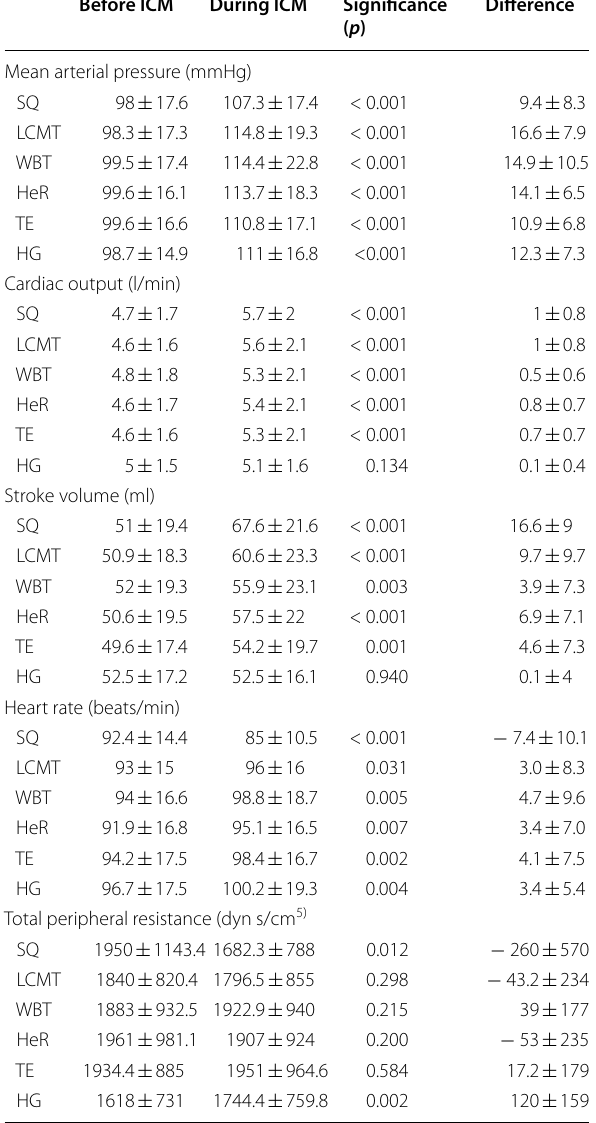
Table 1 Hemodynamic parameters during ICM